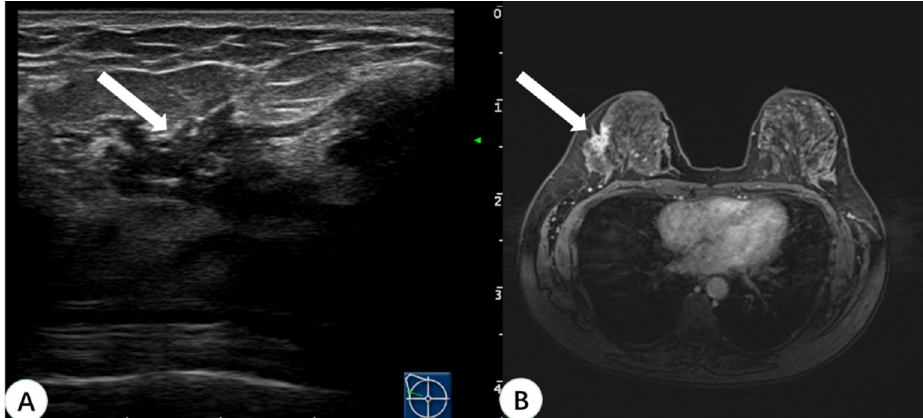
Figure 5. A 44-year-old woman with dense breast tissue underwent virtual navigation: ( A ) Real-time US with virtual navigation revealed the corresponding lesion (arrow) in the right breast at the 10-o’clock position 5 cm from the nipple, which underwent ultrasound-guided biopsy; ( B ) CE-MRI showed a non-mass enhanced lesion (arrow) in the upper outer right breast, undetected on second-look US. Pathology obtained by ultrasound-guided biopsy with virtual navigation demonstrated sclerosing adenopathy with intraductal papilloma formation. US = ultrasound; CE-MRI = contrast-enhanced magnetic resonance imaging.